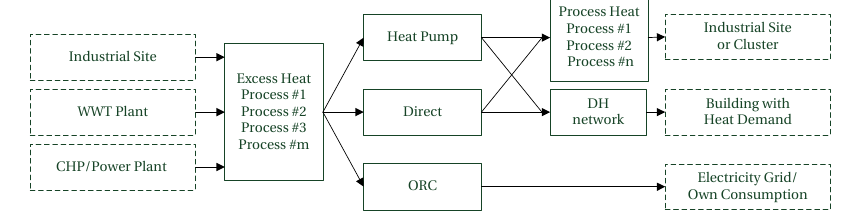
Figure 2. Utilization pathways for excess heat from different